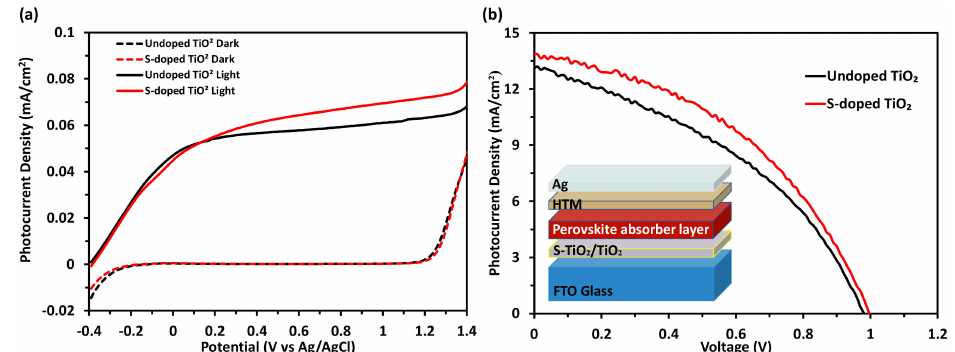
Figure 6. ( a ) LSV responses of the un-doped and S-doped TiO 2 photo-anode in the dark and visible light-irradiated environment and ( b ) photo-current–voltage curve of the perovskite solar devices based on the S-doped TiO 2 and TiO 2 measured under standard AM1.5G illumination and the planar PSC structure